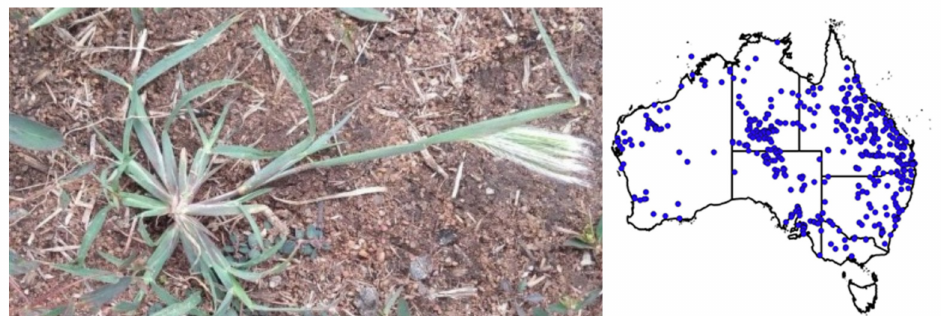
Figure 1. Feathertop Rhodes grass plant and its distribution in Australia, adapted from Atlas of Living Australia [21].